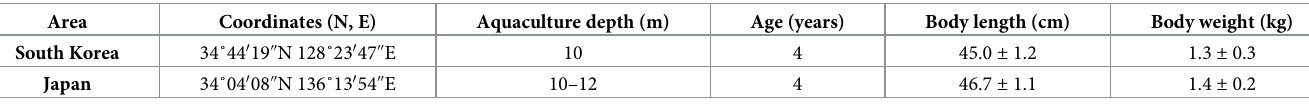
Table 1. Basic and geographic information of red seabream samples used in this study.